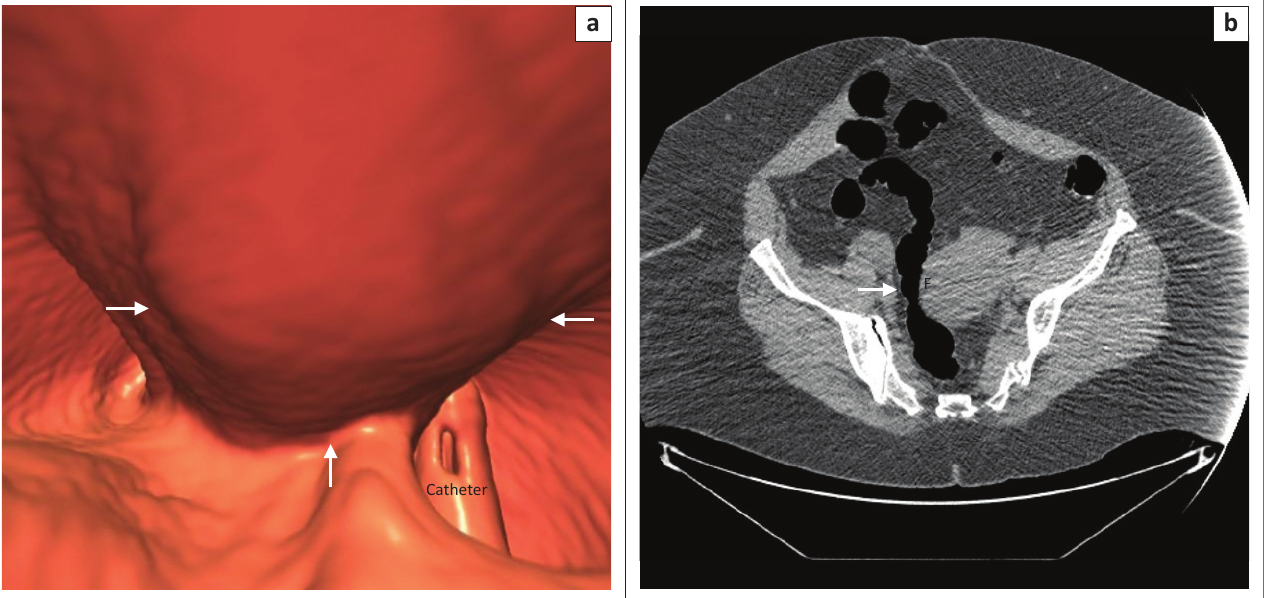
FIGURE 19: (a) 3D view showing an extrinsic impression from a pedunculated uterine fibroid (arrows); (b) 2D axial showing pedunculated uterine fibroid (F) causing narrowing of rectum (white